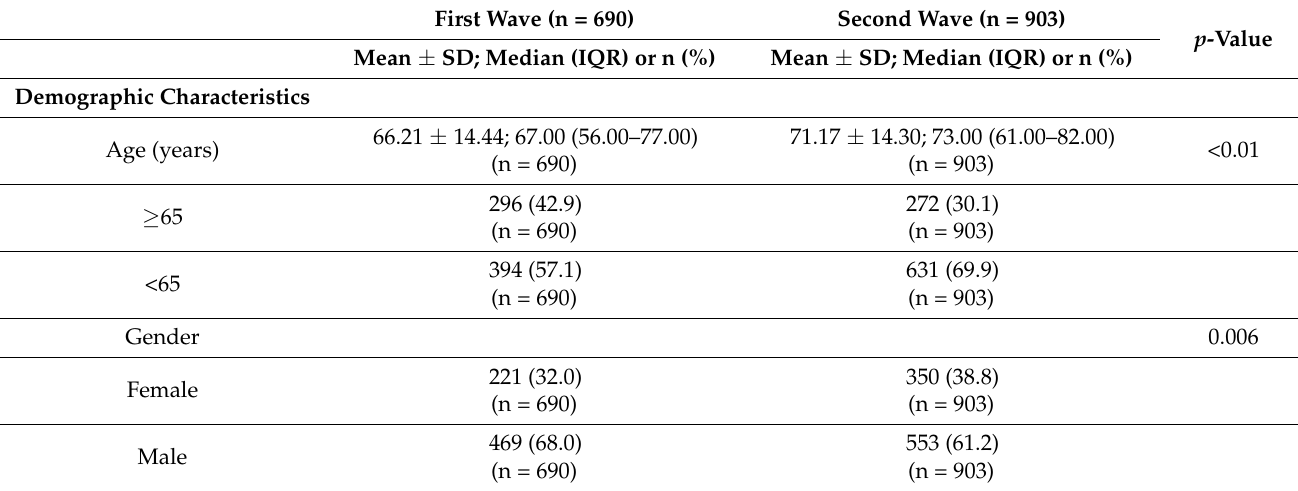
Table 1. Demographic, clinical, and laboratory characteristics of hospitalized COVID-19 patients (n =